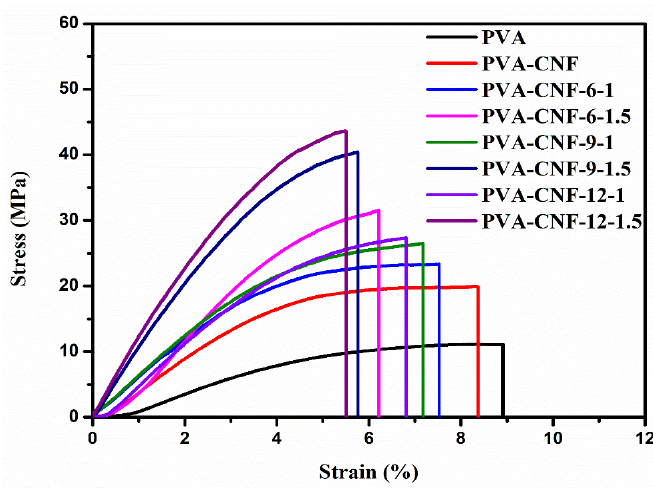
Figure 8. Stress–strain curves of neat PVA and PVA/CNF Figure 8. Stress – strain curves of neat PVA and PVA/CNF films. Figure 8. Stress – strain curves of neat PVA and PVA/CNF films.